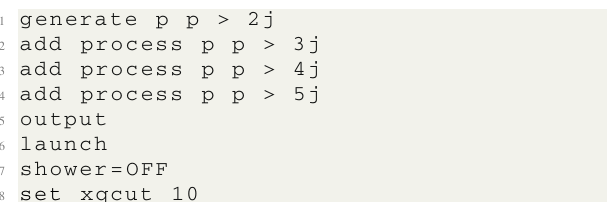
ever,theoverallcomputationtimeisdominatedbythehighest multiplicity sample due to lower event generation efficiency and slower matrix-element